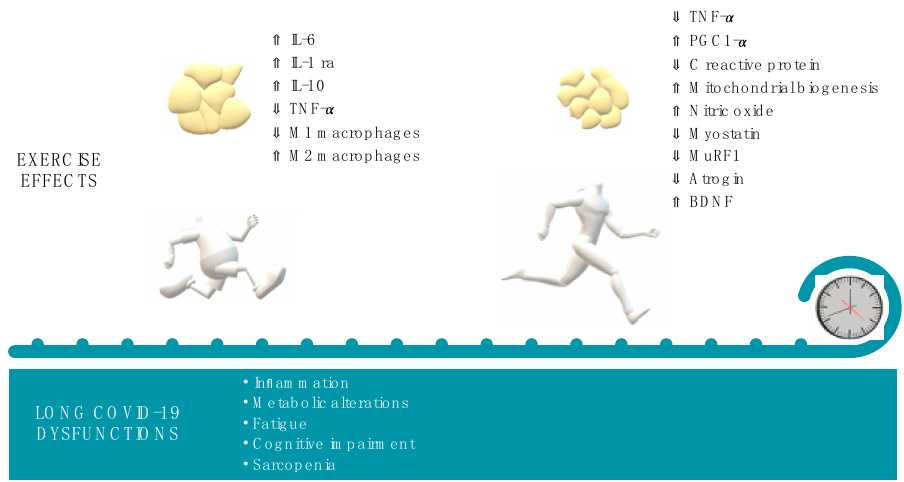
Figure 3. Effects induced by acute and chronic exercise on molecular mediators potentially involved in long COVID-19.